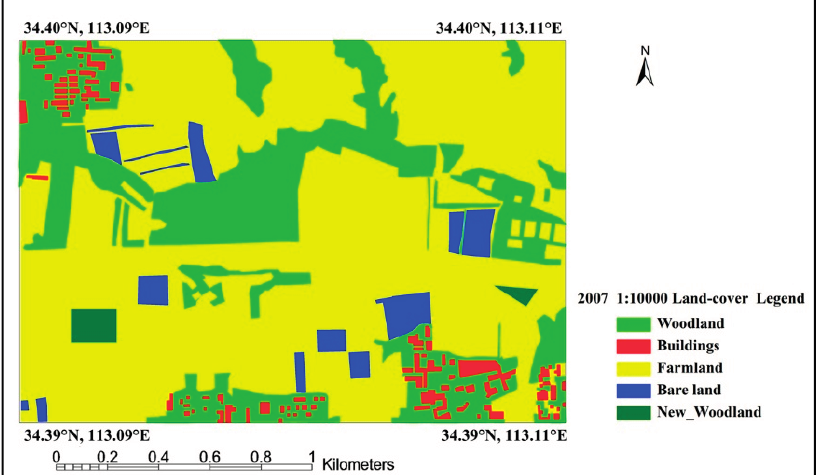
Figure 3. 1:10,000 land-cover map of the study